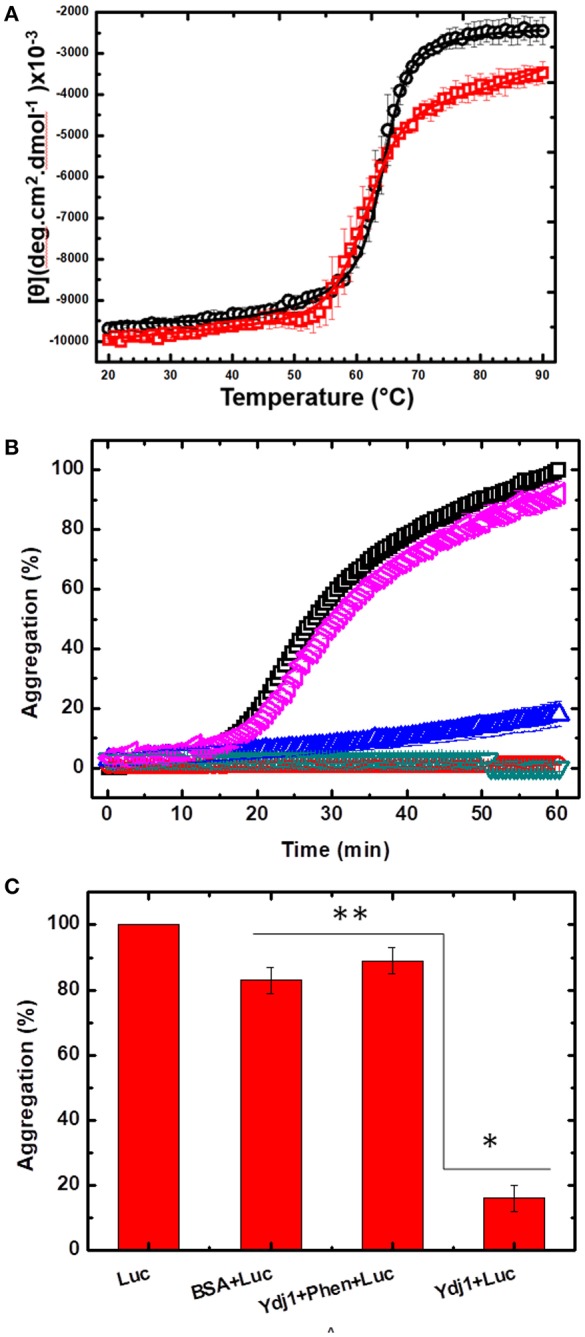
The effect of Zn removal on the stability and chaperone function of Ydj1. (A) Heat-induced unfolding was measured by heating Ydj1 before (red squares) and after (black circles) the Zn removal procedure; the samples were heated from 20 to 90°C, and the CD signal was measured at 222 nm. Data were fitted using Origin. (B) Chaperone activity. Luciferase aggregation at 37 °C was monitored by light scattering (turbidity) (black square). Ydj1 alone, either before (red inverted triangle) or after (green inverted triangle) the Zn removal process remains folded during the process. Ydj1 before (blue triangle) the Zn removal process protected luciferase against aggregation but did not after (pink inverted triangle) the Zn removal process. (C) Bar chart summarizing the protection efficiency of Ydj1 before and after Zn removal, using luciferase as the client protein, against aggregation during heat at 37°C for 60 min [as shown in (B)]. *p > 0.05 and ** p < 0.05. Bovine serum albumin (BSA) was used as a control, showing that the mere mixture with any polypeptide did not prevent protection against aggregation.